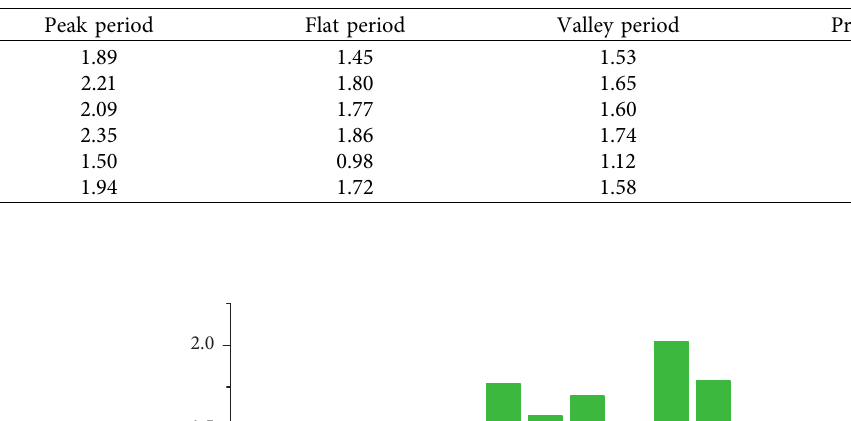
Table 3: TOU tariffs of peak-flat-valley period in different regions.